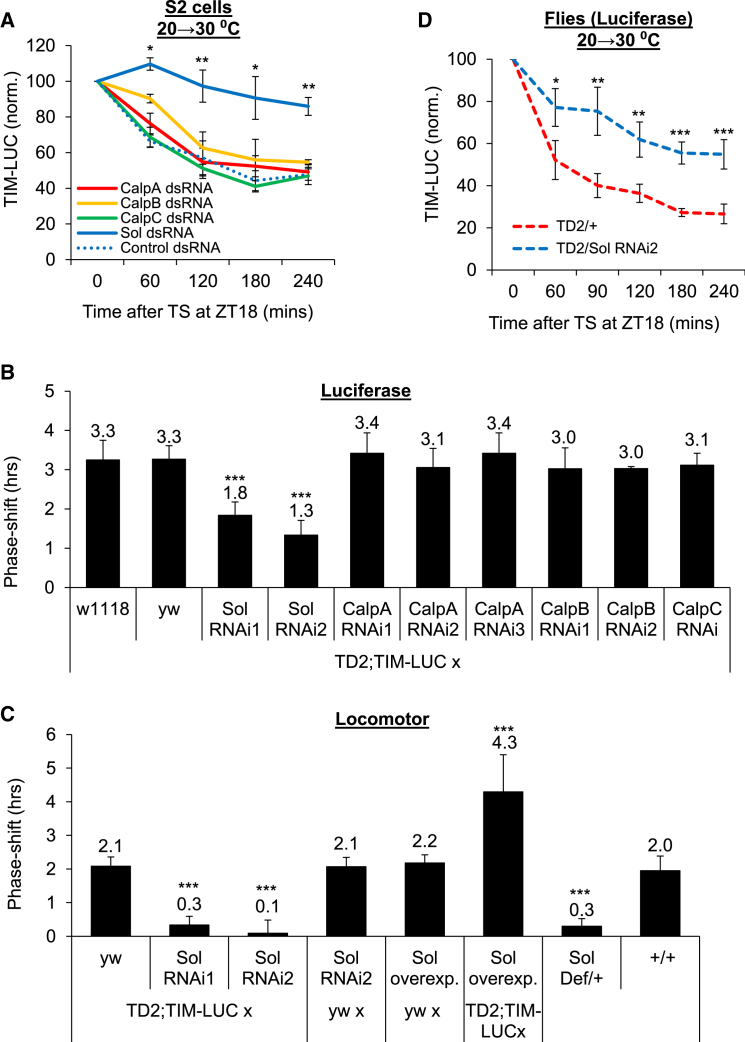
Thermal TIM Degradation and Phase Advances Are Mediated by SOL(A) Downregulation of Drosophila SOL, but not calpain A, B, or C, impairs TIM degradation in S2 cells.(B and C) Two non-overlapping SOL RNAis block thermal phase advances in the periphery (B) and brain (C), while RNAi against the other calpains has no effect. SOL overexpression increases, and deficiency blocks phase shifts in the brain.(D) SOL RNAi reduces TS-induced TIM degradation in whole flies in vivo. Error bars represent SEM for (A) and (D) or SD for (B) and (C). p < 0.05, p < 0.01, or p < 0.001 from at least five independent experiments (n ≥ 6 each) is indicated with “∗,” “∗∗,” or “∗∗∗,” respectively.See also Figure S4.